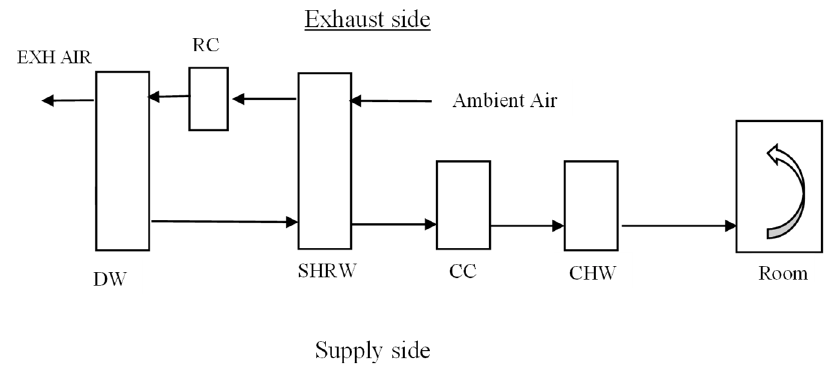
Figure 1. A proposed solid desiccant-based hybrid cooling system.